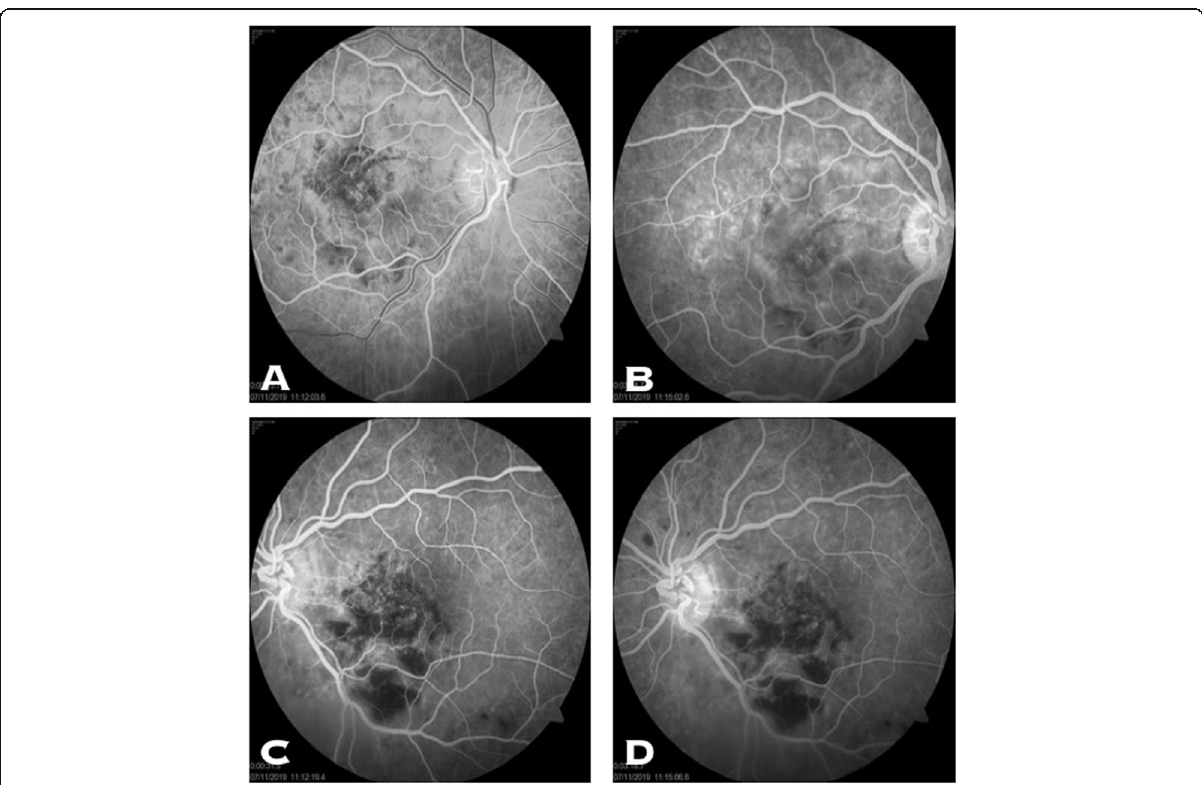
Fig. 4 a and b FA of the RE showing early blockage of background fluorescence in area of active lesion with irregular staining corresponding to RPE atrophy, followed by late staining of the retinitis lesions. c and d FA of LE showed patchy hyperfluorecence corresponding to RPE atrophic patches with blocked fluorescence corresponding to intraretinal